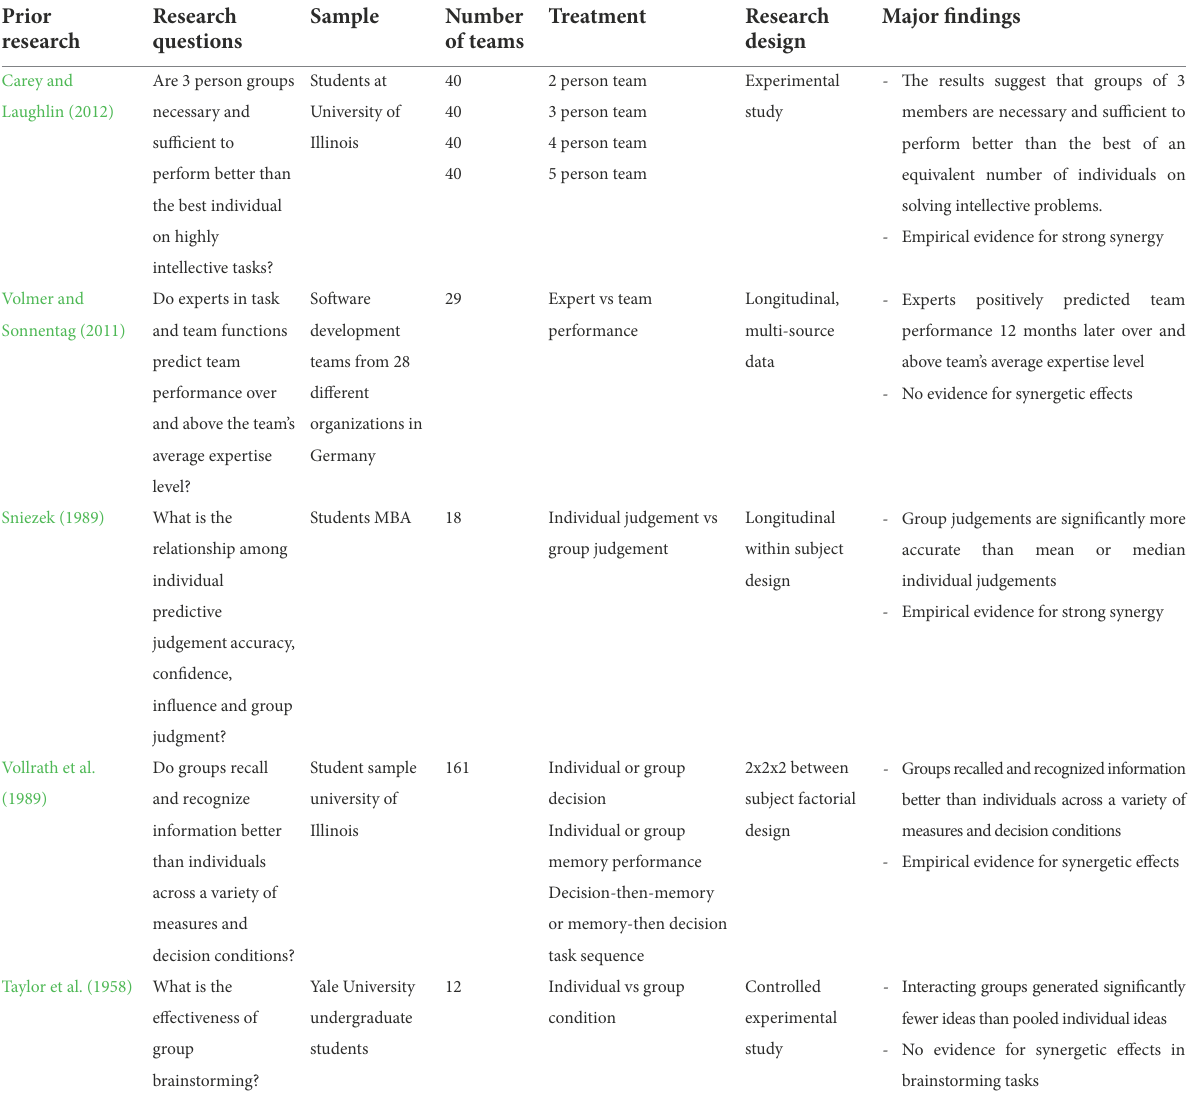
TABLE 2 Representative sample of the strong and weak synergy literature stream in teams. Prior